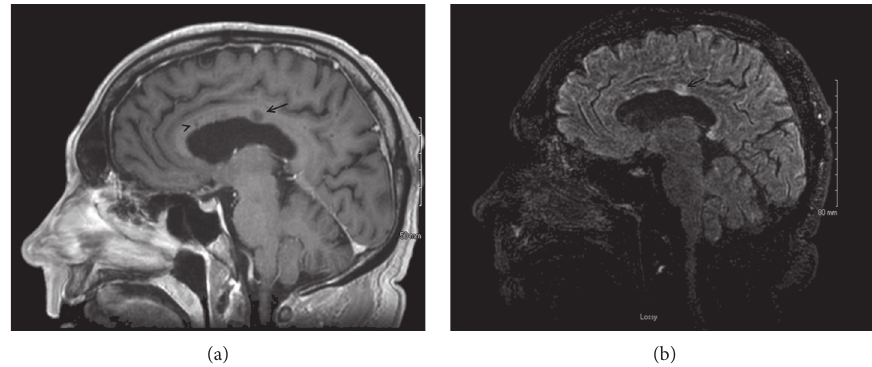
Figure 1: Sagittal views at the level of the corpus callosum during active susac syndrome. (a) T1-weighted. Note . The 6-7mm T1 hypodensity in the body of the corpus callosum was consistent with a “snowball” lesion (demarcated by an arrow), and T1 linear hypodensity sparing the calloseptal surface of the corpus callosum was consistent with a linear “spoke” or “icicle” lesion (demarcated by an arrow head). (b) Sagittal T2/FLAIR-weighted imaging with gadolinium contrast. Note . The increased T2/FLAIR signal and contrast enhancement in the “snowball” lesion (demarcated by an arrow) were consistent with active susac